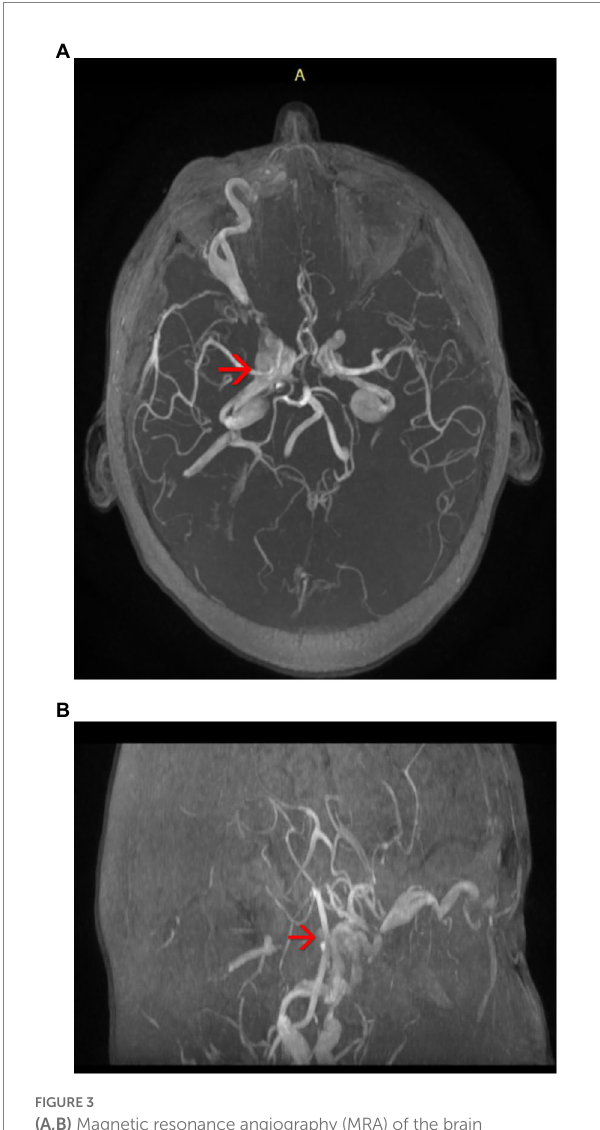
FIGURE 3 (A,B) Magnetic resonance angiography (MRA) of the brain highlighting the arterialization of the cavernous sinus (axial plane) – see red arrows.